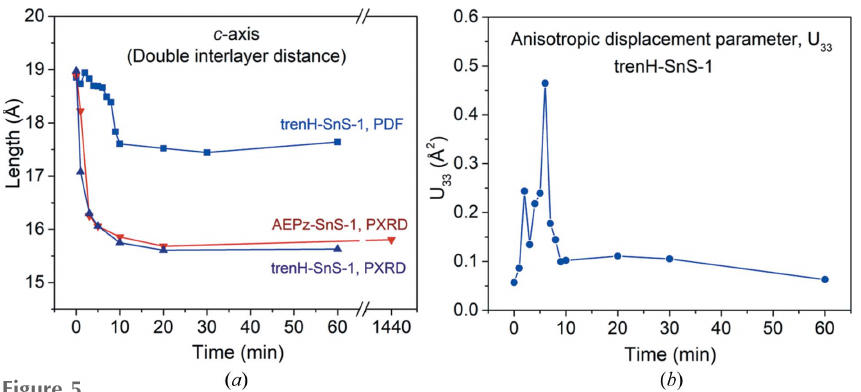
Figure 5 ( a ) The double interplanar distance (corresponding to the crystallographic c axis) as a function of time in water as obtained from PXRD (AEPz-SnS-1 and trenH-SnS-1) and PDF (trenH-SnS-1). ( b ) The displacement parameter U 33 ( i.e. perpendicular to the [Sn 3 S 72 (cid:2) ] n plane) of the tin atoms using an anisotropic trenH-SnS-1 PDF model (Table S3). The lines are guides to the